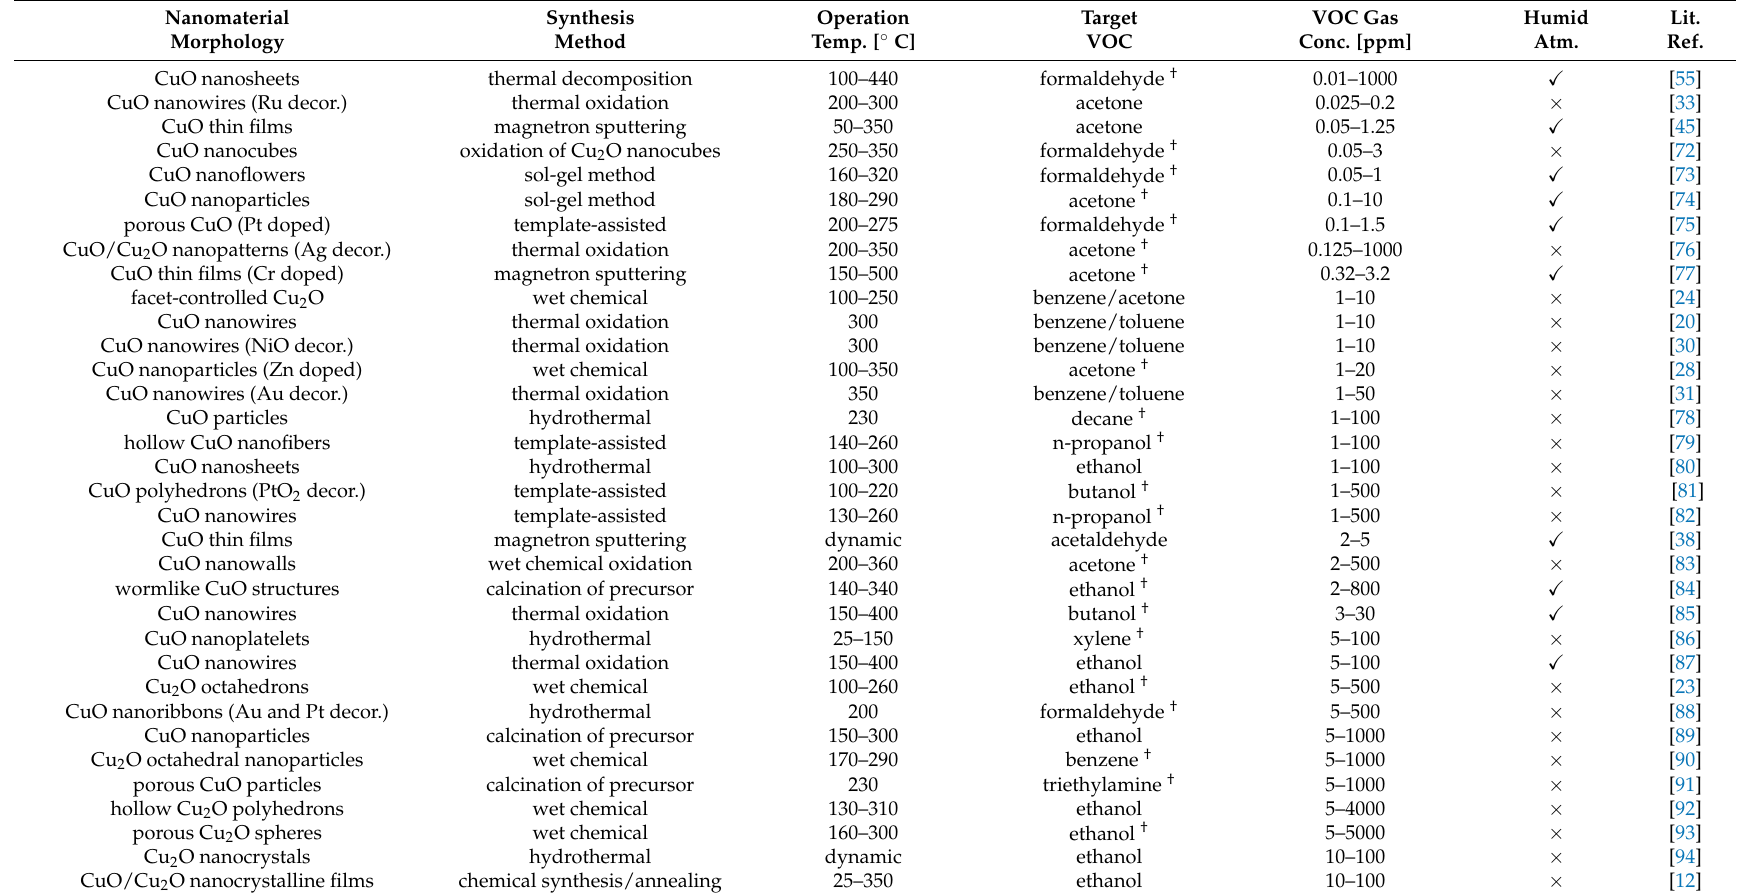
Table 1. A summary of sensing volatile organic compounds (VOCs) with copper oxide-based devices. If the detection of several VOCs was reported, the target VOC is marked with †